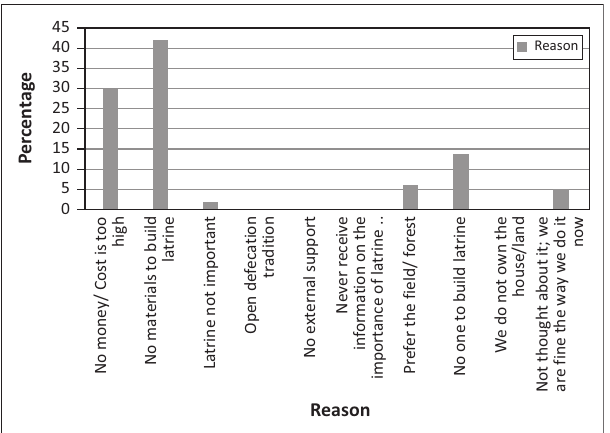
FIGURE 11: Reason for not constructing a latrine after Community Led Total Sanitation